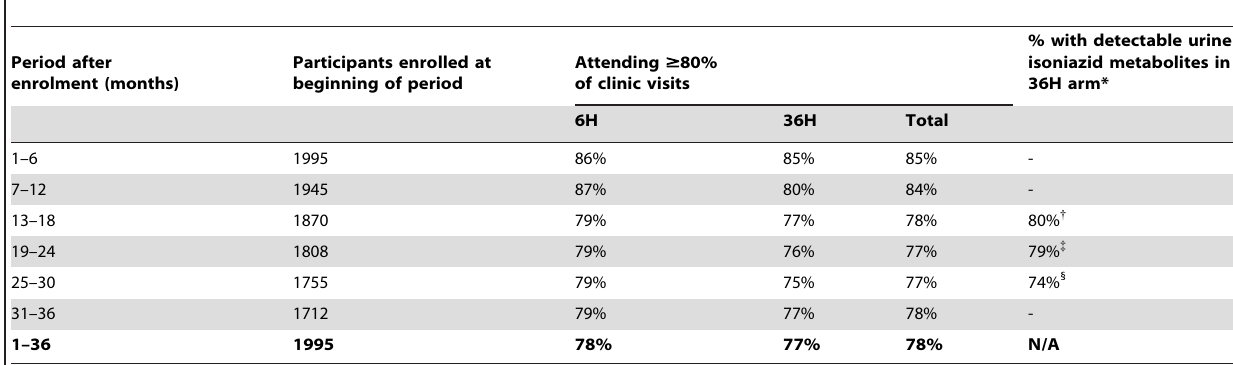
Table 1. Pharmacy refill rates and urine testing for isoniazid metabolites among participants of the Botswana Isoniazid Preventive Therapy Trial,